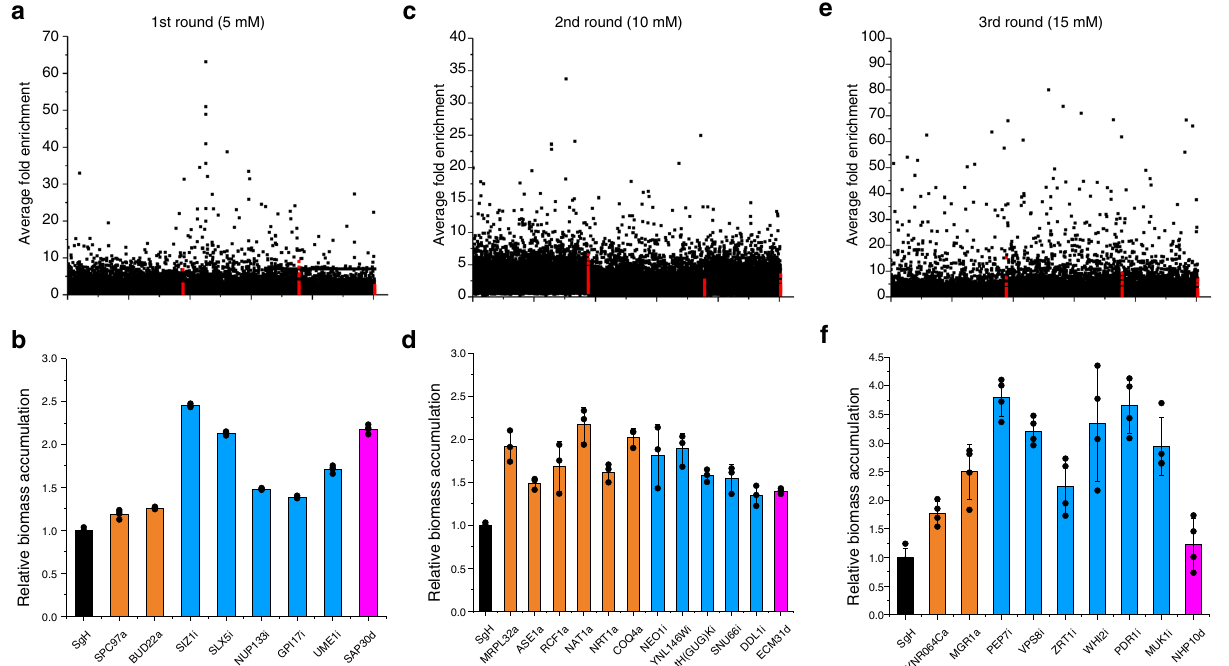
Fig. 2 Iterative MAGIC enabled genome-wide mapping of furfural tolerance in yeast. The iMAGIC library was subject to iterative rounds of screening under gradually increased furfural concentration, 5, 10, and 15 mM for the fi rst a , b , second c , d , and third e , f round of iMAGIC screening, respectively. The guide sequences of the enriched libraries were pro fi led a , c , e using next-generation sequencing and the top hits were veri fi ed b , d , f under the corresponding screening condition. The red dots represented the control guide sequences. Orange bars represented activation targets, light blue for repression, and magenta for deletion. Error bars represent the mean ± s.d. of biological triplicates. The source data for fi gures b , d , and f are provided as a Source Data fi